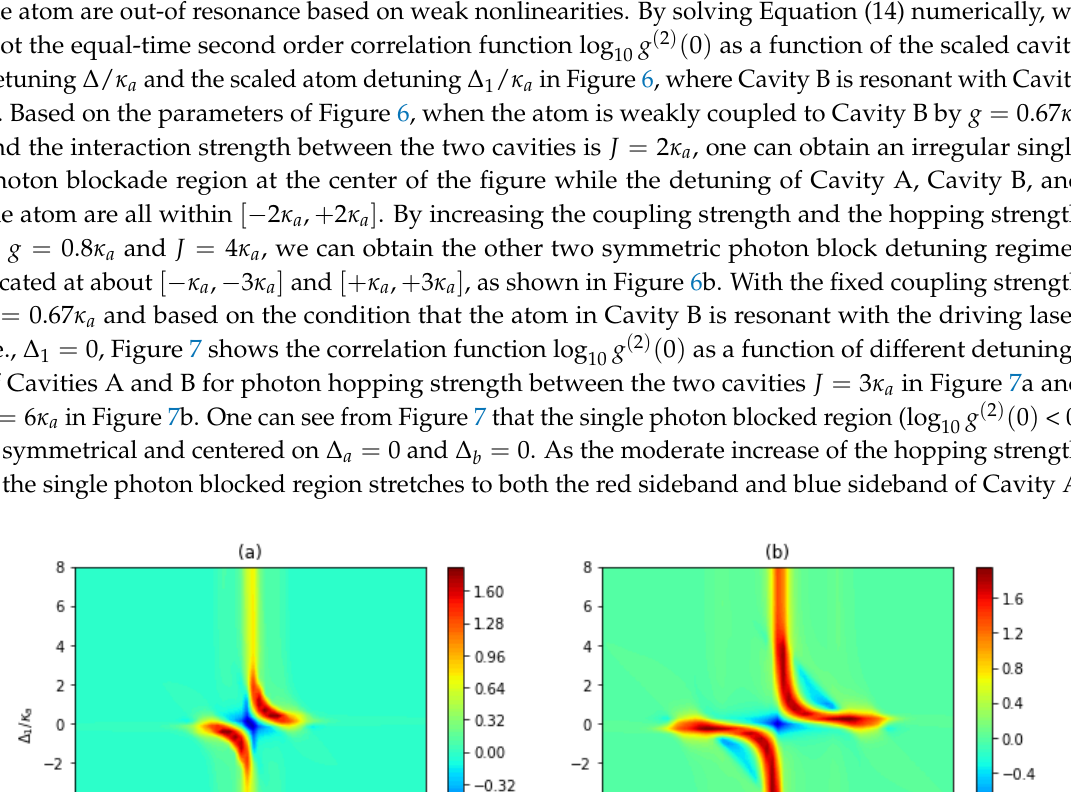
J  under the resonant a